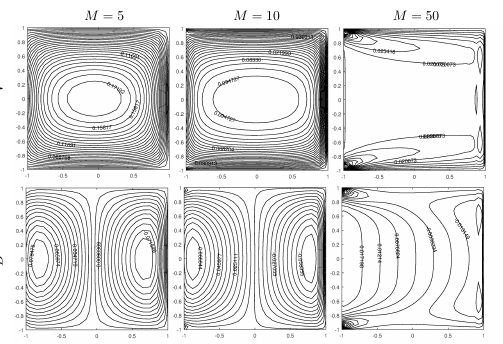
Figure 6. Velocity and induced magnetic field from inverse solution, π β = 2